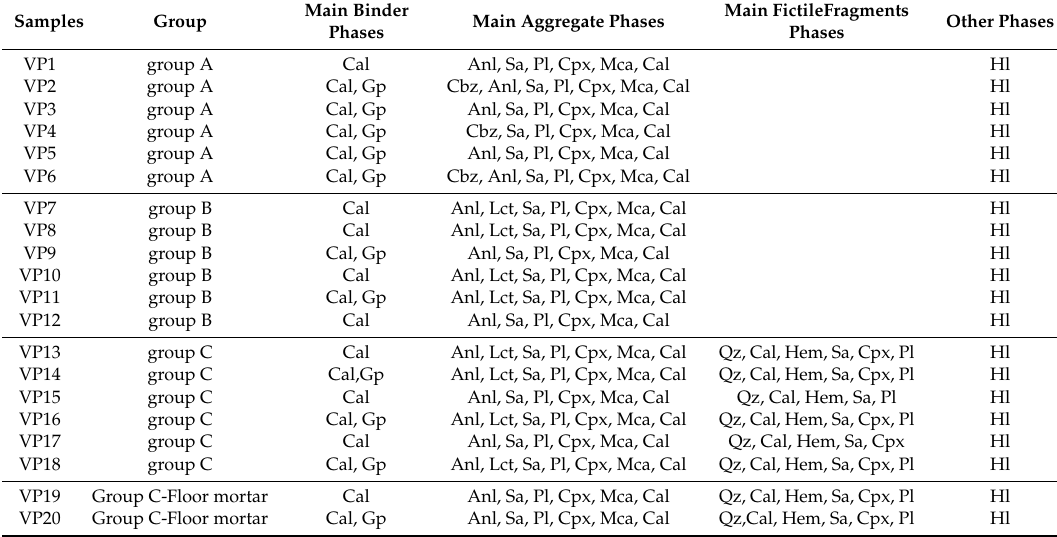
Table 3. Qualitative mineralogical composition of samples, XRPD analysis—mineral abbreviations from Whitney and Evans [32].